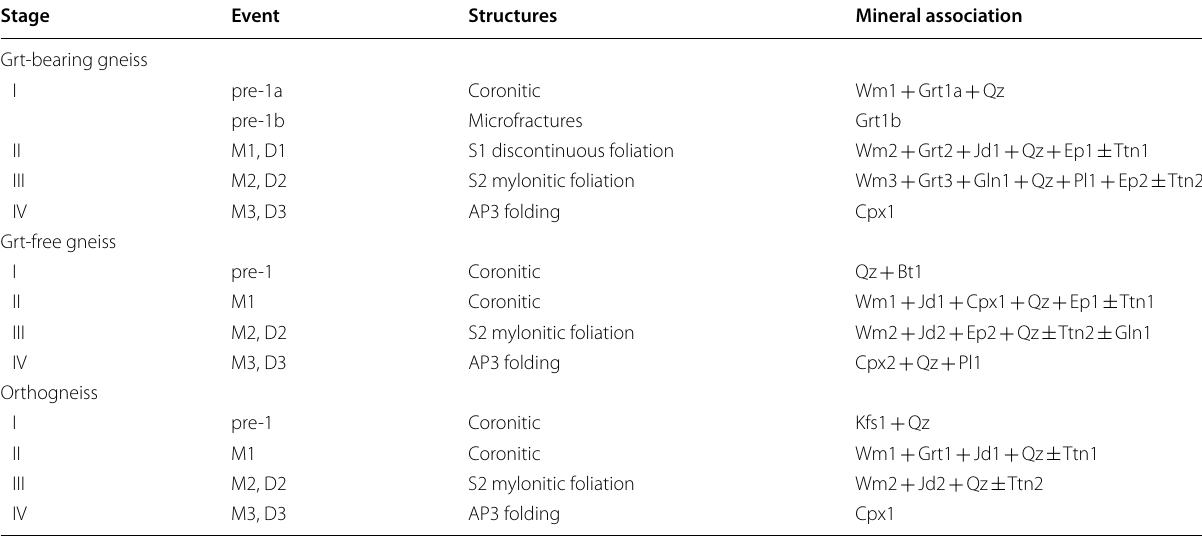
Table 1 Summary of deformation-metamorphic transformation stages with characteristic structures and mineral